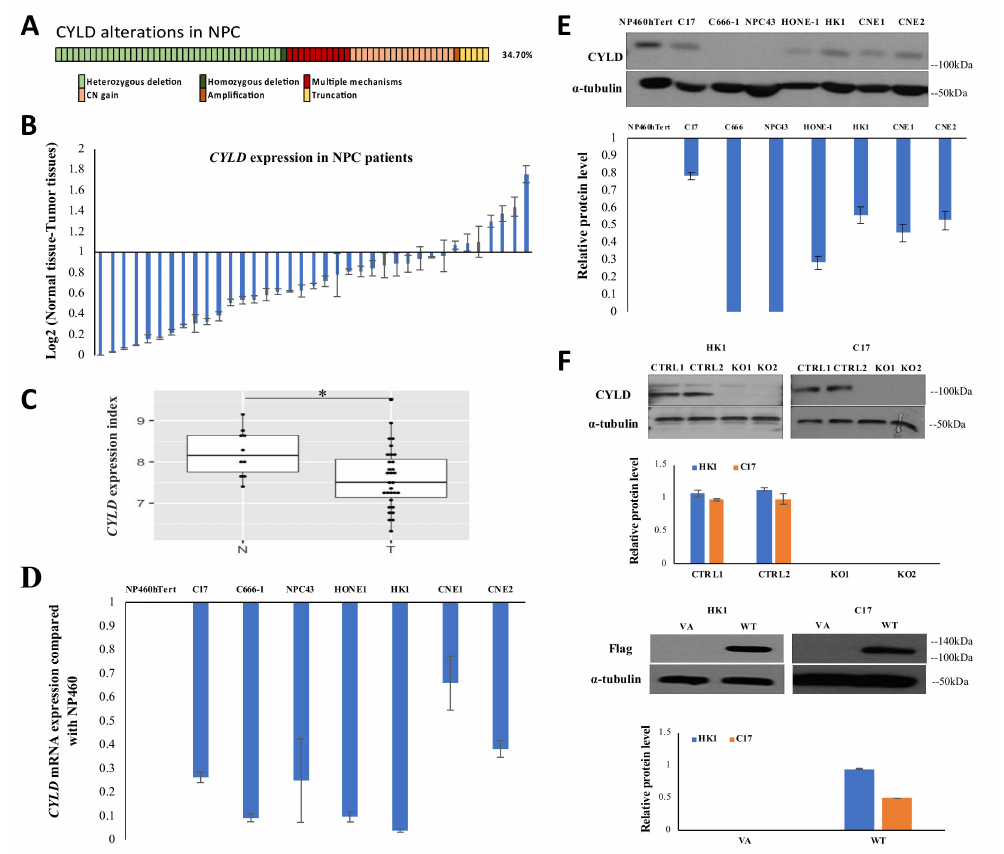
Figure 1. CYLD expression in NPC cell lines and clinical patients. ( A ) Integrative genomic analysis identified CYLD somatic alterations in 34.7% of cases. ( B ) A total of 37 pairs of NPC normal / tumor tissues were used for real-time quantitative polymerase chain reaction (qRT-PCR) analysis. CYLD mRNA was down-regulated in 30 of 37 (81%) cases. The data shown are represented as mean ± standard deviation (SD); n = 4. ( C ) Publicly available microarray data (GSE12452) show that CYLD was significantly downregulated in NPC tumors (31 cases) compared to normal tissues (10 cases). N: normal; T: tumor. *: p -Value < 0.05. ( D ) The qRT-PCR result shows CYLD mRNA expression was downregulated in C17, C666-1, NPC43, HONE-1, HK1, CNE1, and CNE2 compared to NP460hTert. ( E ) The western blot result shows that CYLD protein was downregulated in seven cell lines compared to NP460hTert. The α -tubulin was used as the loading control. Quantification by densitometry is shown in the bar graph. ( F ) Two pairs of sgRNA-targeted CYLD were utilized to create a functional knockout of CYLD and two pairs of sgRNA-nontarget were utilized as the control in HK1 and C17, as verified by western blots. The overexpression e ff ect of FLAG-tag CYLD / VA plasmid infection of HK1 and C17 cell lines was verified by western blot with quantification by densitometry, as shown in the bar graph. CTRL1: nontarget control1; CTRL2: nontarget control2; KO1: CYLD -targeted knockout1; KO2: CYLD -targeted knockout2. VA: overexpression vector-alone; WT: overexpression CYLD wild-type. The whole